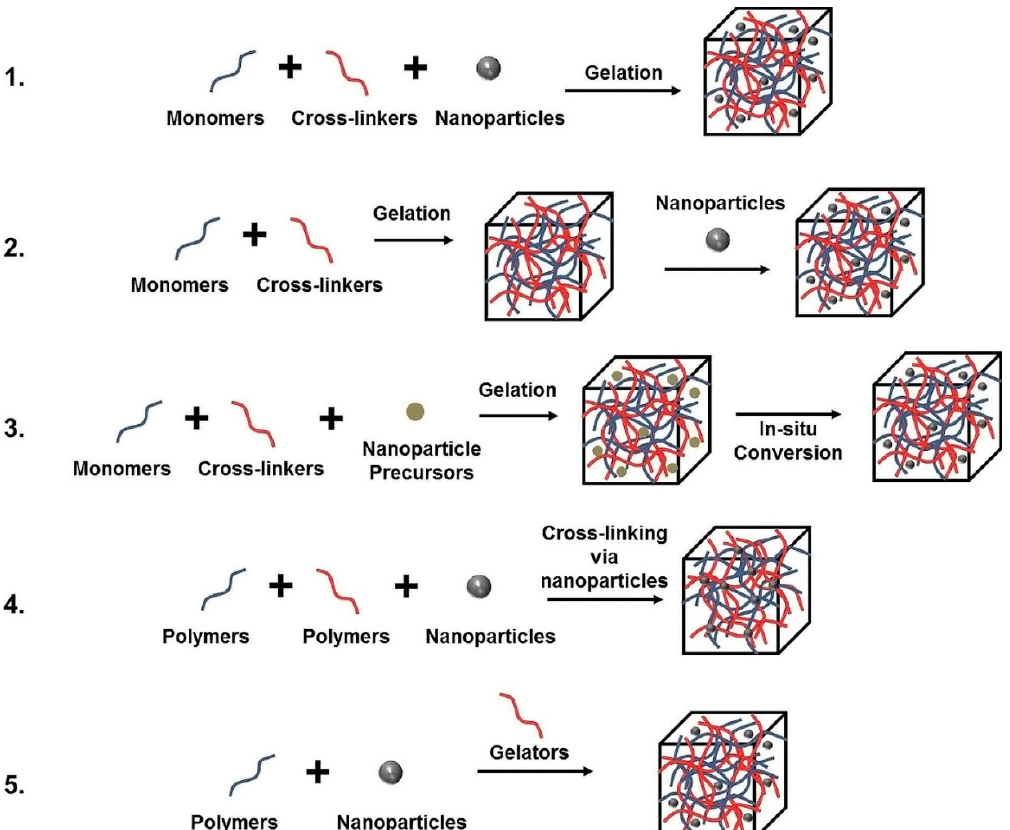
Figure 2. Five main approaches used to obtain hydrogel-nanoparticle conjugates with uniform distribution: ( 1 ) hydrogel formation in a nanoparticle suspension, ( 2 ) physically embedding the nanoparticles into hydrogel matrix after gelation, ( 3 ) reactive nanoparticle formation within a preformed gel, ( 4 ) cross-linking using nanoparticles to form hydrogels, ( 5 ) gel formation using nanoparticles, polymers, and distinct gelator molecules. [40]. https://creativecommons.org/licenses/by/4.0/.